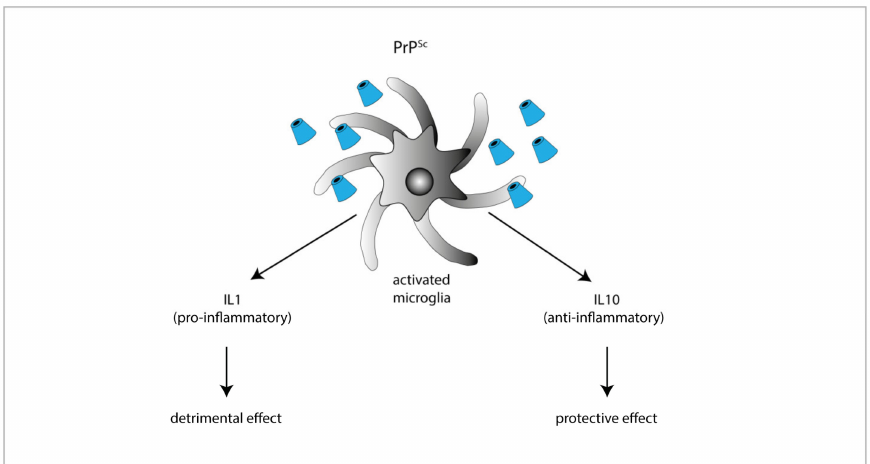
Figure 2. Exposure to PrP Sc or prion mimetics (e.g., the fibrillogenic 106-126 peptide) activates microglial cells promoting the secretion of either pro-inflammatory IL-1 (resulting in enhanced neurodegenerative cues), or anti-inflammatory IL-10 (exerting neuroprotective e ff